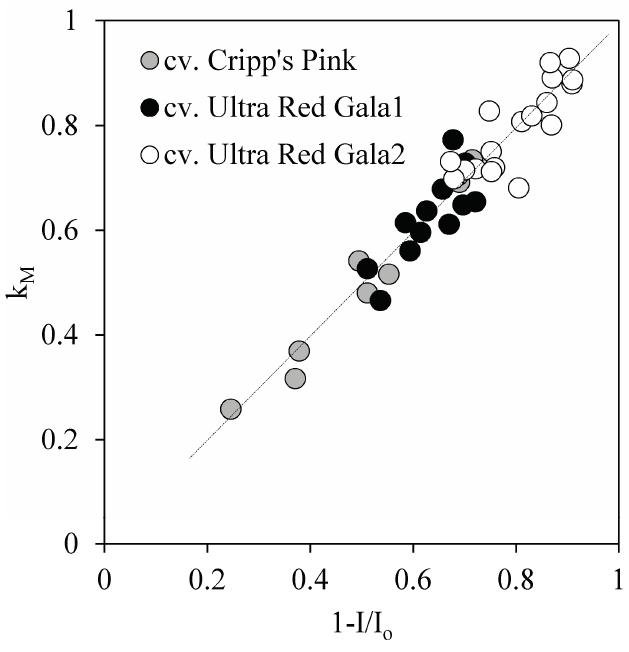
Figure 3. Relationship between measured light extinction coefficient (k M ) and the fraction of light intercepted by the canopy (I c = 1 − I/I o ) for both